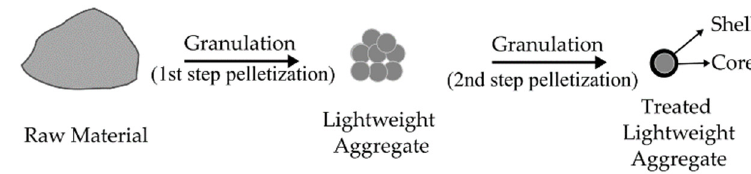
Figure 4. Two-step